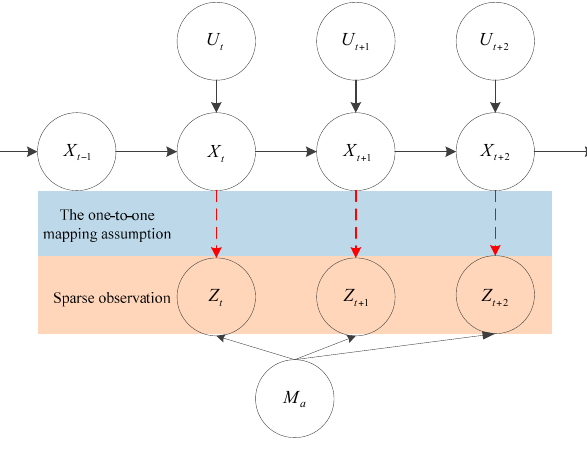
Figure 7. The generative probabilistic model for filtering.